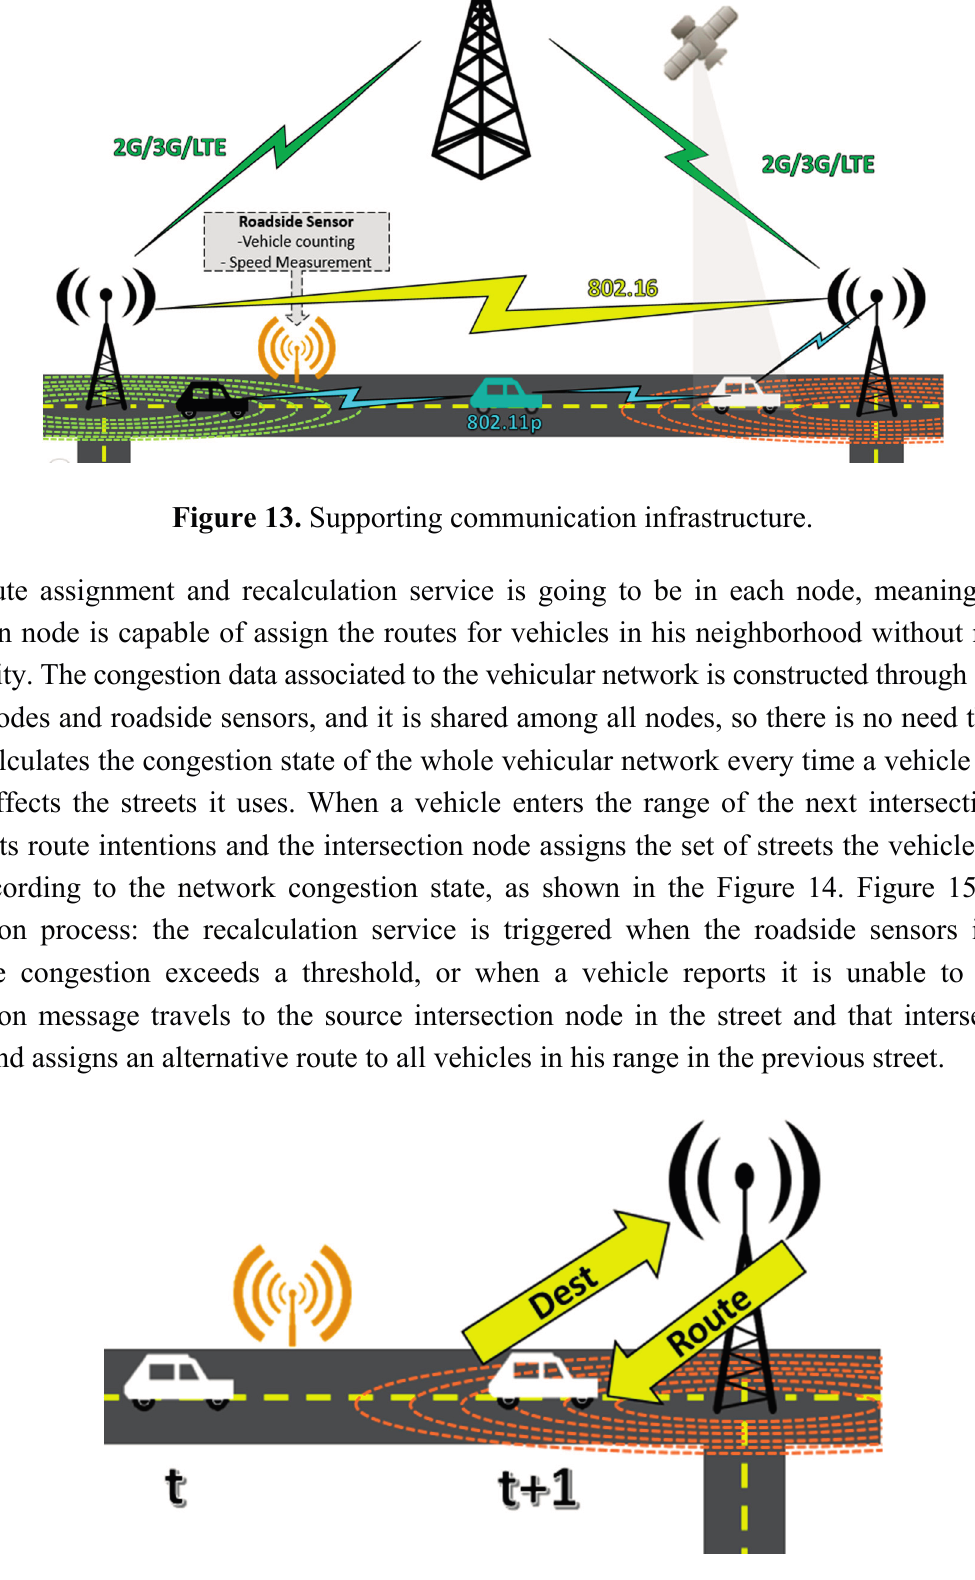
Figure 14. Communication between vehicle and intersection